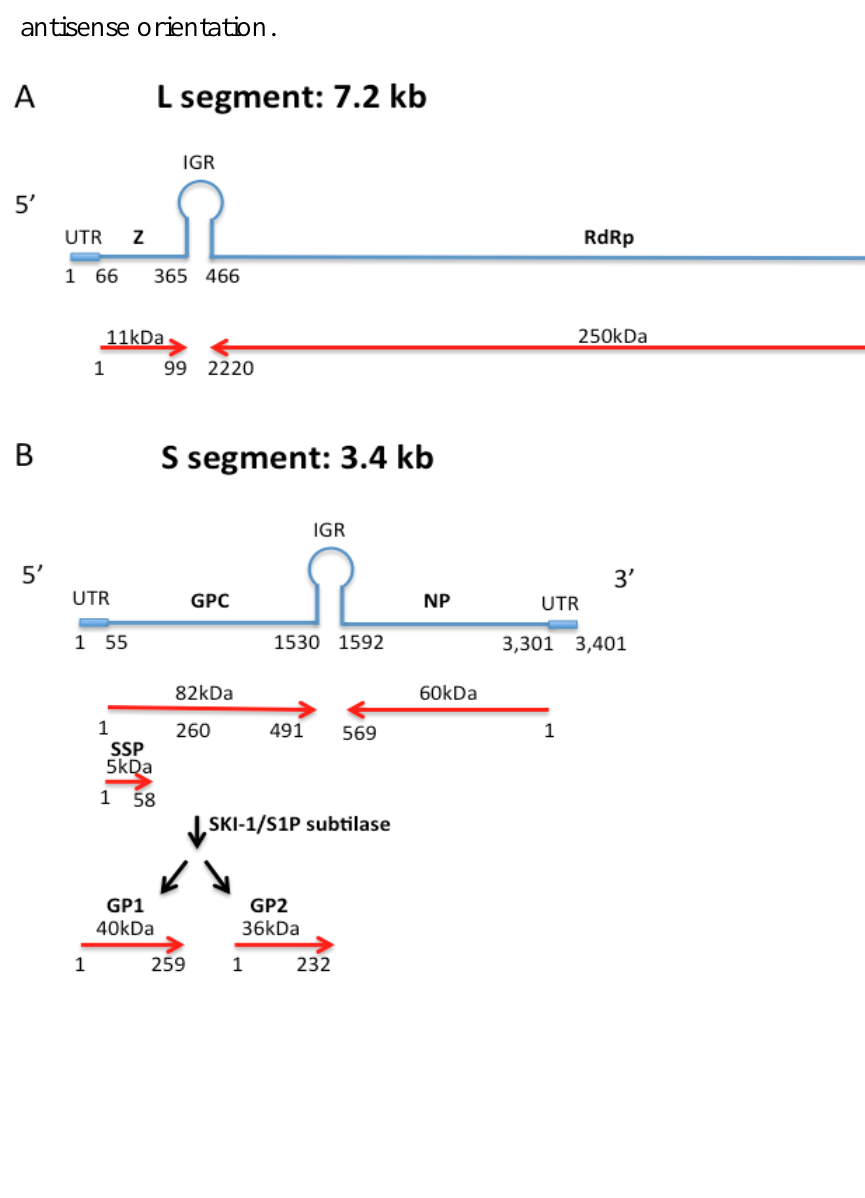
Figure 1. Arenavirus genome structure from 5’ to 3’ end. A ) The LASV L genome segment (7.2 kb) is represented in blue and is composed of an untranslated region (UTR) from nucleotide 1 to 66 and from 7129 to 7285, the gene encoding the zinc-binding protein (Z) from nucleotide 67 to 365, the intergenic region IGR from nucleotide 365 to 466, and the RNA-dependent RNA polymerase protein encoding gene (RdRp) from nucleotide 466 to 7128. B ) The LASV S segment genome (blue lines) contains the untranslated region (UTR) from nucleotide 1 to 55 and from 3302 to 3401, the gene encoding the glycoprotein precursor protein (GPC) from nucleotide 57 to 1530, the intergenic region IGR from nucleotide 1531 to 1592, and the nucleocapsid protein encoding gene (NP) from nucleotide 1593 to 3301. The red arrows represent the 491 amino acid long GPC with its stable signal peptide (SSP) and glycoproteins 1 and 2 (GP1 and GP2) produced after maturation cleavage. The 569 amino acid long NP is shown encoded in the antisense